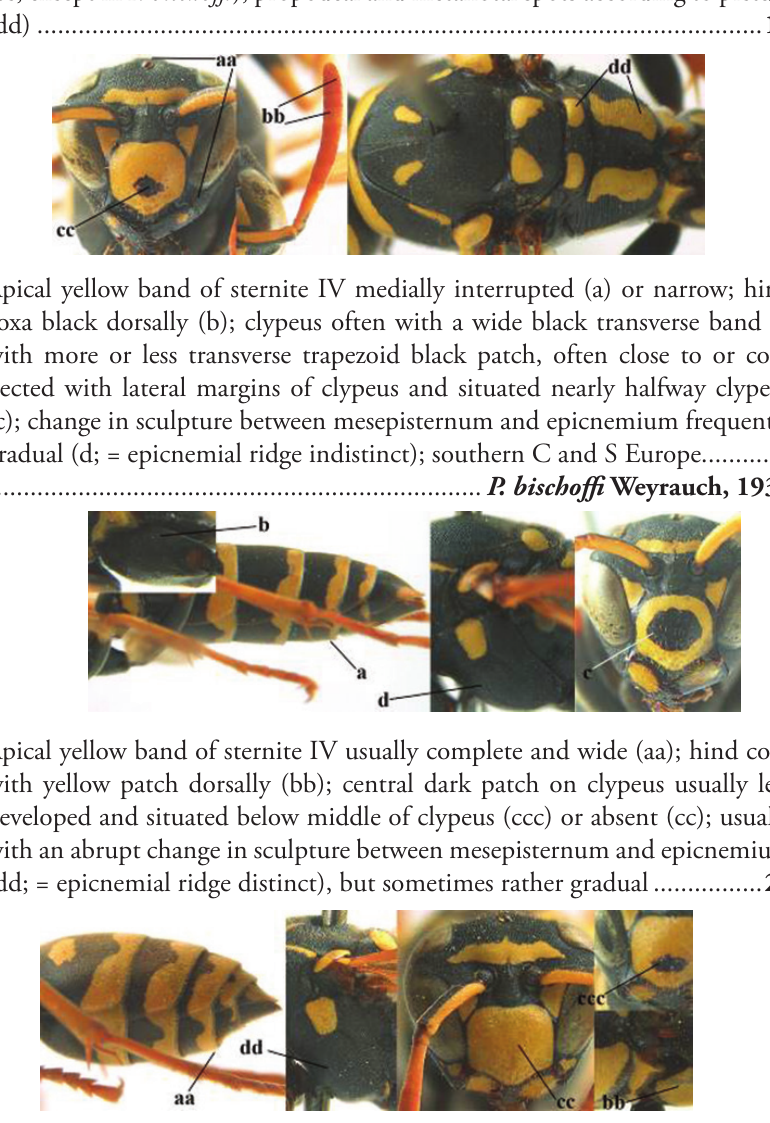
20 Transverse yellow band of pronotum medio-laterally wider than dorso-later- ally (a); central dark patch on clypeus usually developed, but small, rounded or forming a transverse band (b); mesoscutum usually with pair of medium- sized to large yellow spots (c); [some specimens have an all yellow clypeal disk and all black mesoscutum; specimens from NW Africa often have sternite IV apically yellow, which is more or less darkened in northern specimens];